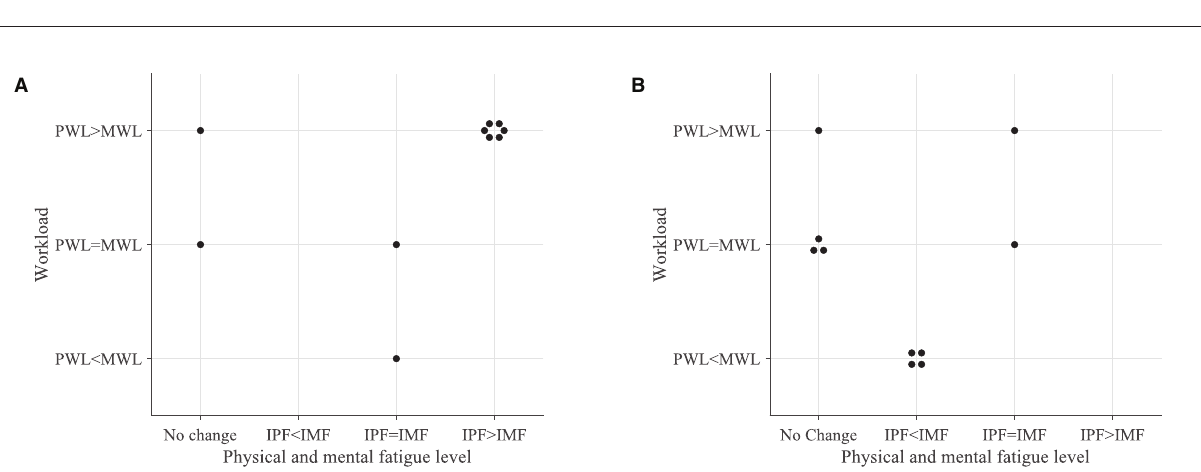
FIGURE 10 | Subjective measures of fatigue level and workload. (A) Comparison of the subjective measures of fatigue level before and after the gross motor interaction with HapticMATER. (B) Comparison of the subjective measures of fatigue level before and after the fine motor interaction with SCRIPT passive orthosis. (C) Comparison of the subjective measures of physical and mental workload following the gross and fine motor interactions.